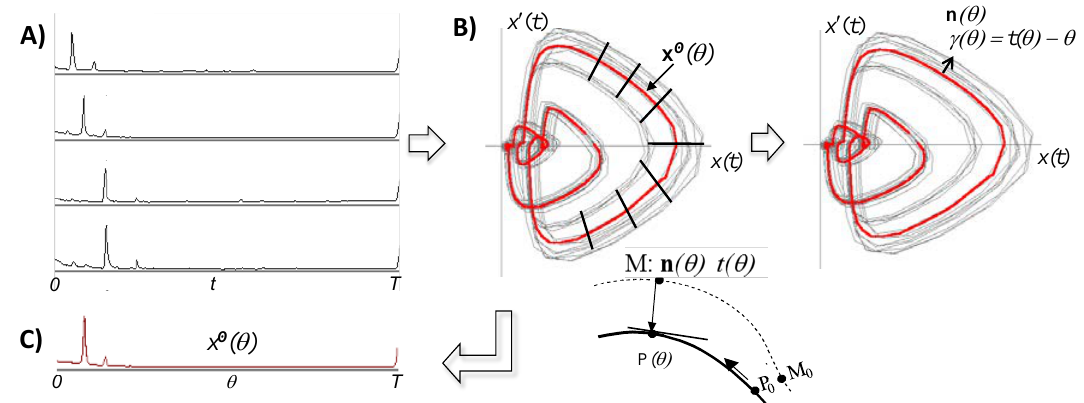
Fig. 1. A) Example of signals with phase shifts stems from chromatographic experiments carried out with High Performance Liquid Chromatography (HPLC) columns. Chromatograms of the same product demonstrate column-to-column, lot-to-lot and day-to-day variations in peak retention time [5]. B) The same set of chromatograms in phase space ( x(t) , x’(t) projection), the mean trajectory